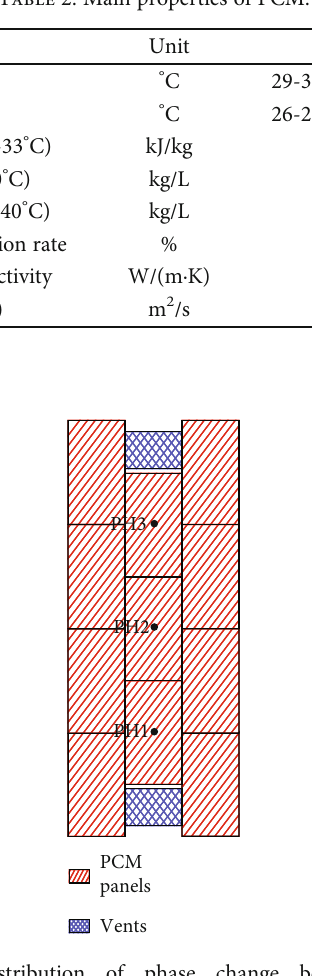
Table 2: Main properties of PCM.